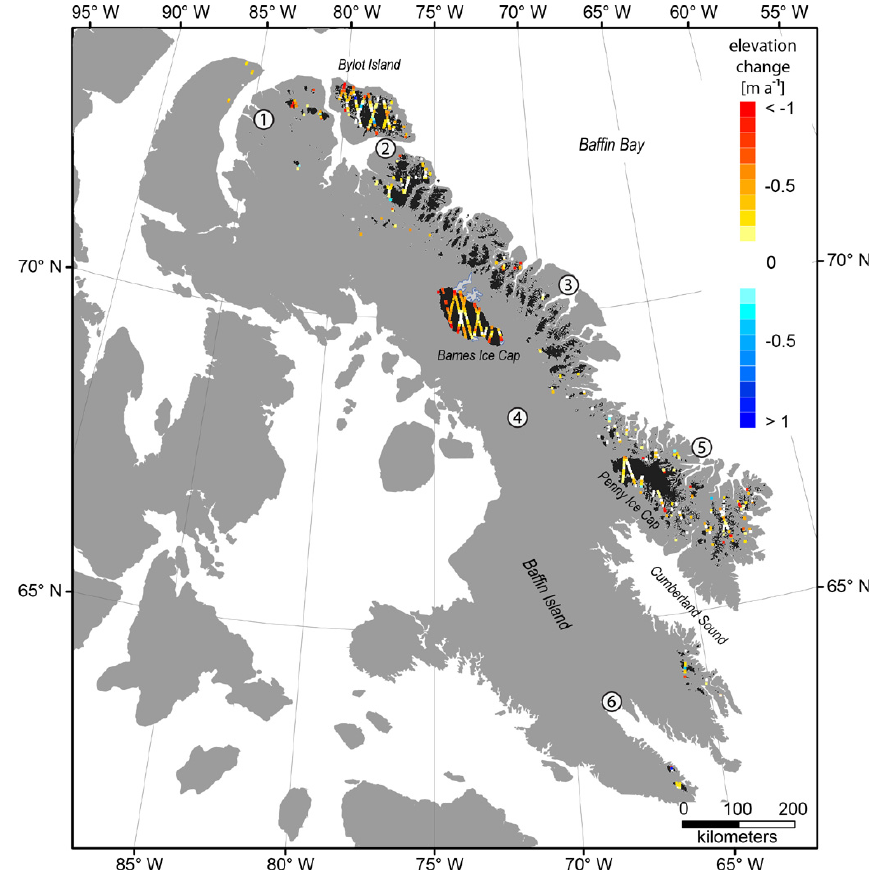
Fig. 1. Elevation change (ma − 1 ) between 1962 and 2006 as determined from ICESat satellite laser altimetry and DEMs generated from airborne stereoscopic imagery (CDED). Numbered dots show the locations of the Environment Canada weather stations used to characterize regional climate (Nanisivik (1), Pond Inlet (2), Clyde River (3), Dewar Lakes (4), Fox Five (5) and Iqaluit